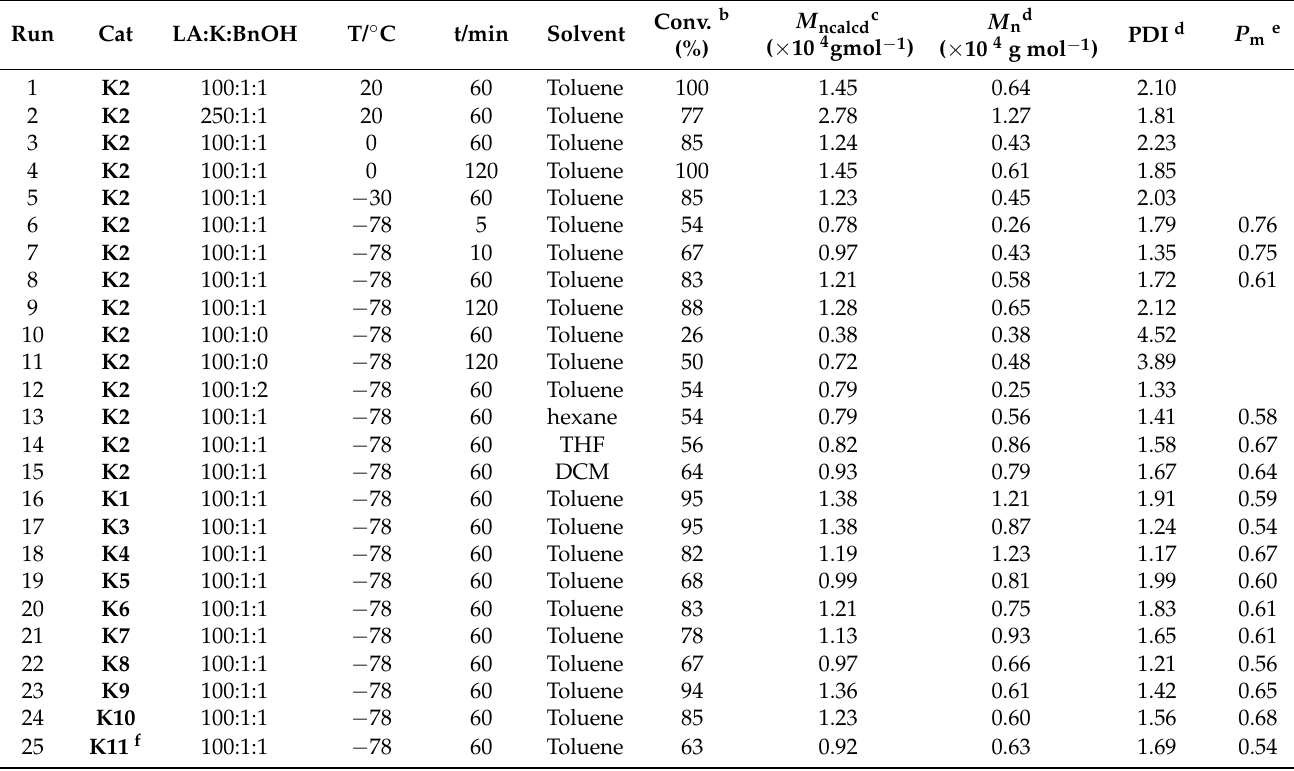
Table 3. Ring-opening polymerization of rac -lactide a